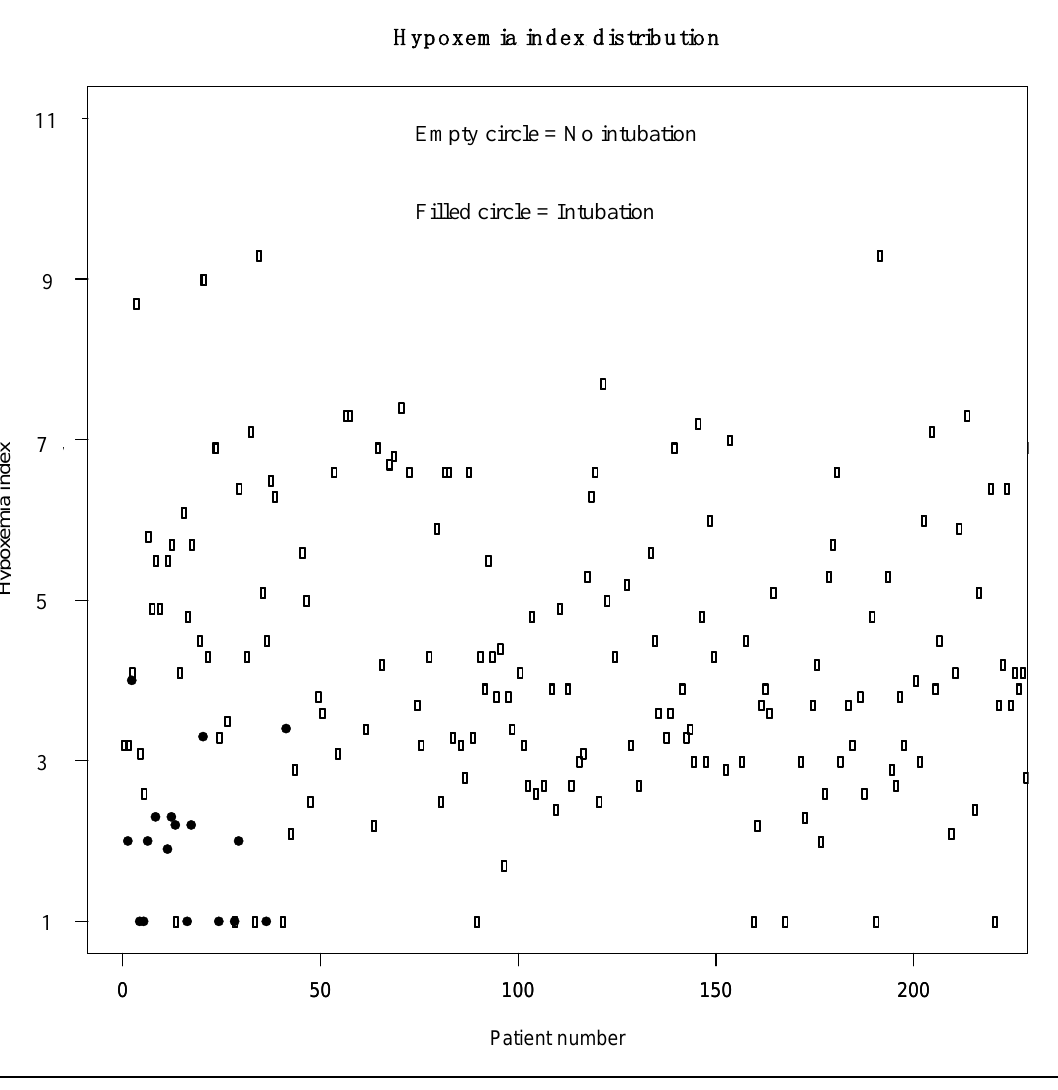
Figure 4. Hypoxemia Index (HI) distribution between intubated and non-intubated patients.